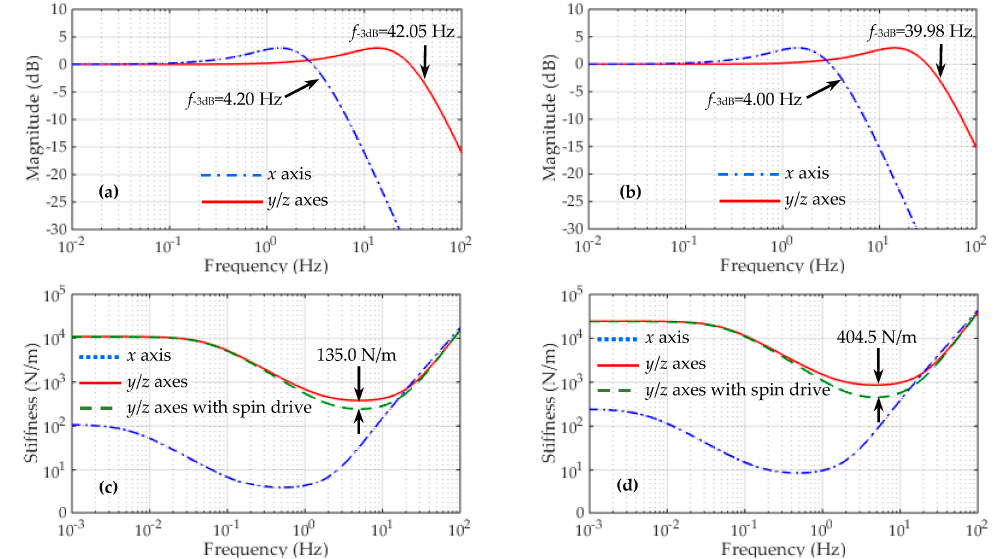
Figure 7. Simulation results of the active suspension control loops for the inner TM (left side) and the outer TM (right side): ( a , b ) Closed-loop frequency responses; ( c , d ) Suspension stiffness of the closed-loop control system.